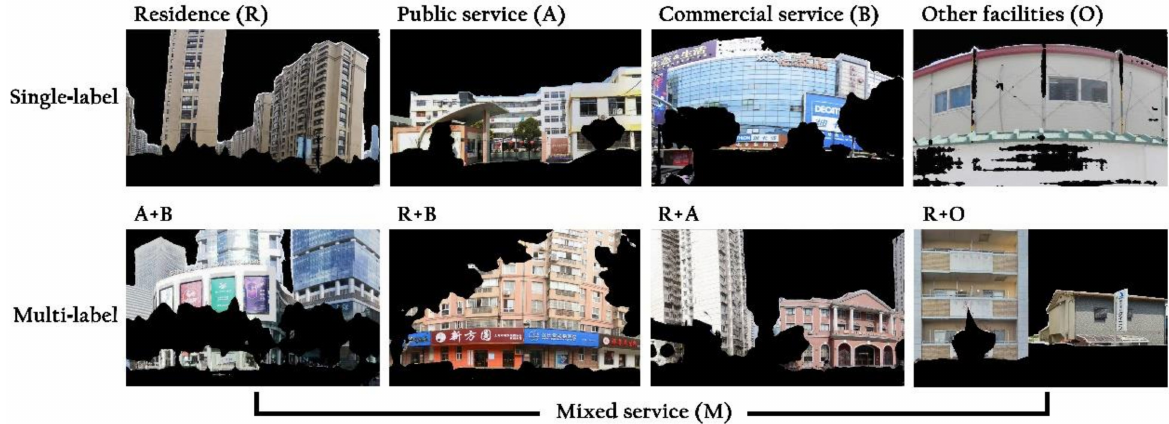
Figure 5. A total of 4965 street view images with four single-labeled and rearranged buildings are included. The first line is single-label class, from left to right: residential, public services, commercial services, and other facilities. The second line is the multi-label class, from left to right: public service and commerce, residence and commercial service, residence and public service, residence, and other facilities.